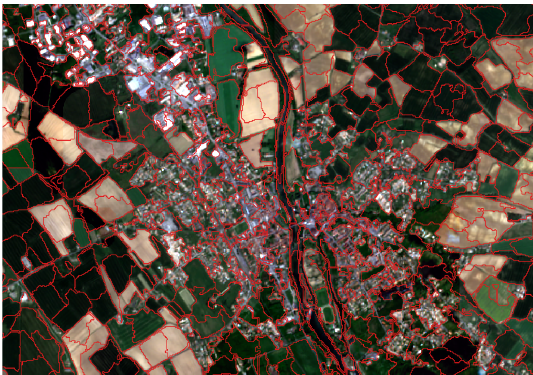
Figure 7. Different segmentations of a Sentinel-2 image time series, on a discontinuous urban fabric. Background: RGB bands of the first date.